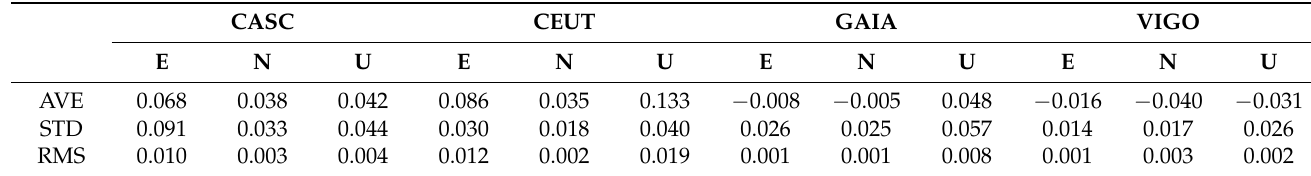
Table 13. Statistics results from the Test 5.